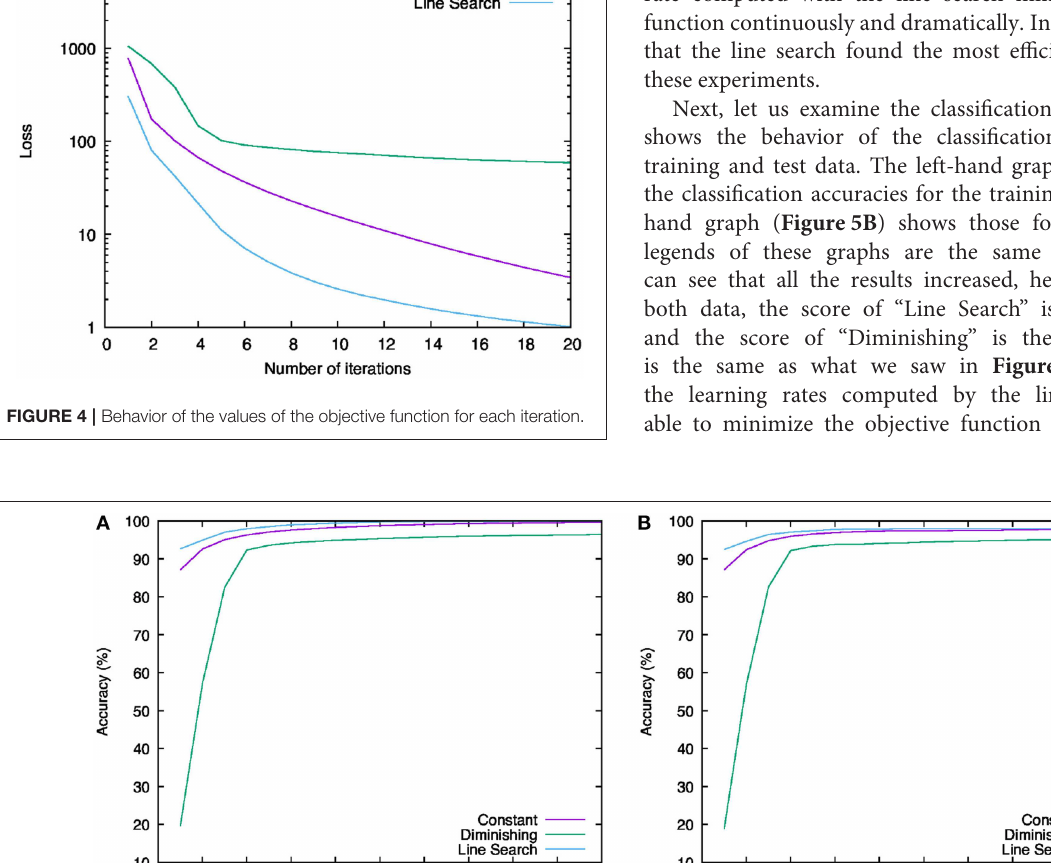
Frontiers in Robotics and AI |